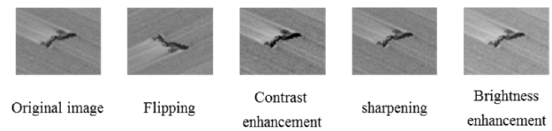
( b ) Figure 13. The Euclidian distance ( d v ) histogram of similar areas and dissimilar areas: ( a ) Similar areas distance histogram; ( b ) Dissimilar areas distance histogram. 2.2. Defect ROI Classification In the classification stage, considering the strong feature extraction and representation ability of the CNN network, we use the inception-v3 [38] network structure to realize the accurate identification of various defects with large intra-class variations and high inter-class similarity. Inception [39] is a popular convolutional neural network model proposed by Google. Its unique and detailed inception block design makes the model increase the depth and width of the network while maintaining the same amount of calculation. The inception-v3 network is the third version. The biggest change of v3 version is to decompose the 7 × 7 convolution kernel into two 1 × 7 and 7 × 1 one-dimensional convolution kernels. In this way, the calculation can be accelerated, and one convolution layer can be divided into two, which can further increase the depth of the network and